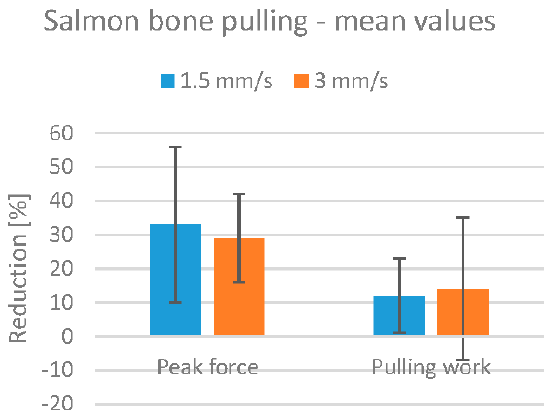
Figure 10. Mean values for the reduction of bone pulling force and work in salmon fillets, with error bars marking corresponding mean standard deviation values. Reduction percentages are calculated relative to the control fillet from the same fish.